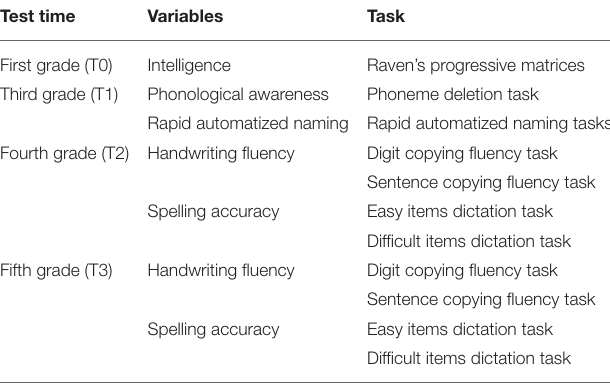
TABLE 1 | Tests and procedures.